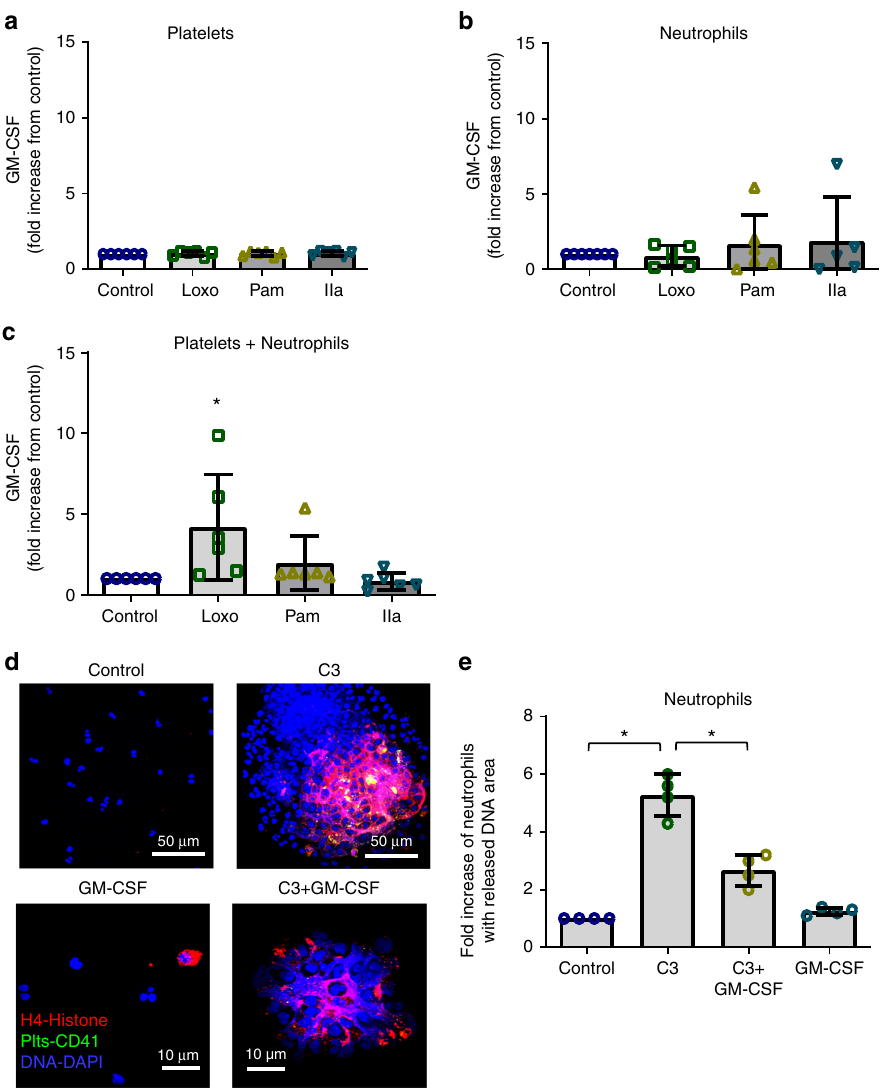
Fig. 6 Role of platelet GM-CSF and C3 in neutrophil-DNA release. a – c Isolated human platelets and neutrophils were incubated together or by themselves for 30 min (at constant rotation and 37 °C) in the presence of TLR agonists [TLR7 (Loxo) — 1 mM; TLR2 (Pam 3 CSK 4 , PAM) — 10 μ g/ μ L] or thrombin (IIa) — 0.05 U/mL. GM-CSF release from a platelets ( p = 0.8903, F = 0.2071, df = 3), b neutrophils ( p = 0.7255, F = 0.4422, df = 3), and c platelets and neutrophils incubated together was measured by ELISA ( p = 0.0200, F = 4.116, df = 3). The graphs represent the average fold change for each individual of n = 6 (3F; 3M) ± SD. d Confocal images of isolated human neutrophils treated with C3 (30 ng/mL) and neutrophils treated with C3 in the presence of GM- CSF (25 ng/mL). Neutrophils were treated in HEPES-modi fi ed Tyrode ’ s buffer (0.04 × 10 5 neutrophils/ μ L) for 30 min at 37 °C, and constant rotation (aggregometer). At the end, cells were fi xed and stained [CD41-FITC-platelets (green); H4-AF637-histone (red); DAPI-DNA (blue)]. Neutrophil-DNA aggregates were visualized by confocal microscopy. Images are representatives of n = 4 different donors. C3-treated neutrophils from healthy donors release their DNA and form large aggregates. e Quantitation of ( d ). The graph ( n = 4, 2F, 2M) is represented as average ( p < 0.0001, F = 71.42, df = 3) ± SD. Signi fi cance in ( a – c , e ) was assessed using ANOVA followed by Bonferroni multiple comparison test and star symbol (*) indicates p < 0.05. Source data are provided as a Source Data fi